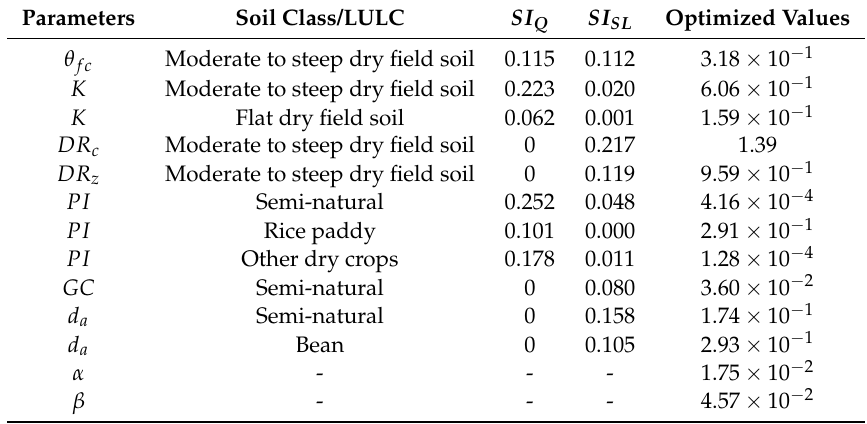
Table 6. List of important parameters ( SI > 0.05) for stream discharge ( SI Q ) and suspended sediment ( SI SL ), and their optimized values from DE